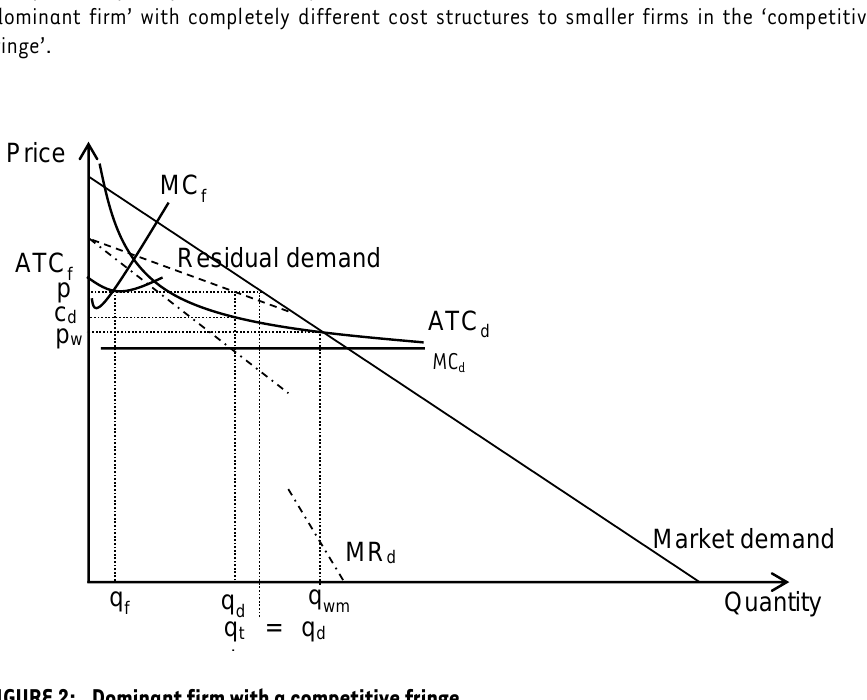
FIGURE 2: Dominant firm with a competitive fringe